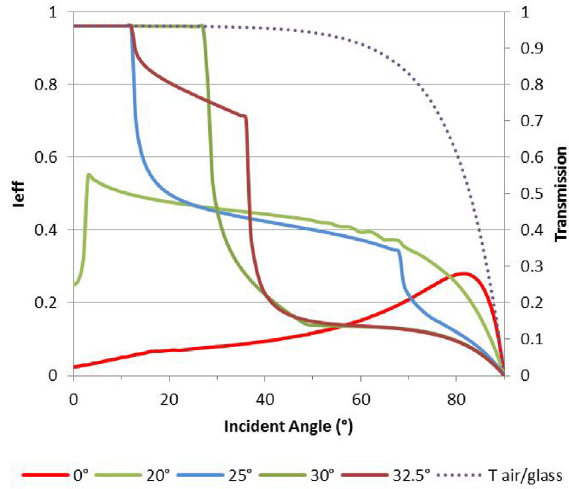
Fig. 6. I eff for different pyramid slope angles and correspond- ing incidence